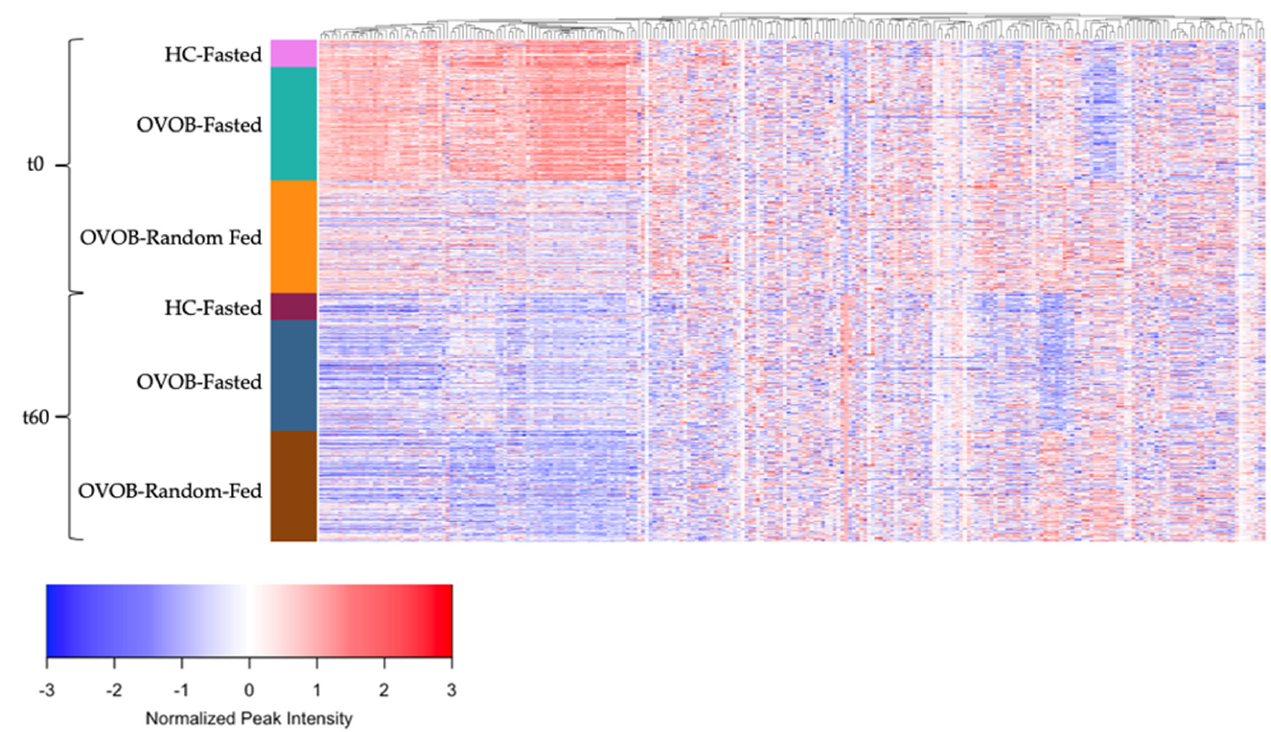
Figure 4. Dynamic response of the metabolome to an oral glucose tolerance test. Heatmap of normalized peak intensity for individual metabolites ( p = 246) (mean 0, standard deviation 1). Metabolites are grouped by hierarchical clustering (columns). Subjects are ordered by group (OVOB and lean), time point after the OGTT (t0 and t60), and state (Fasted and Random-Fed) (rows). OVOB, overweight and obese.